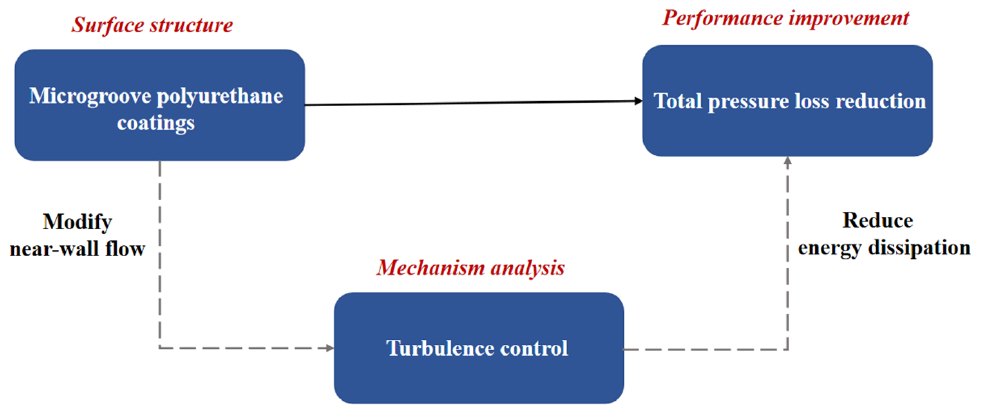
Figure 1. The research framework.